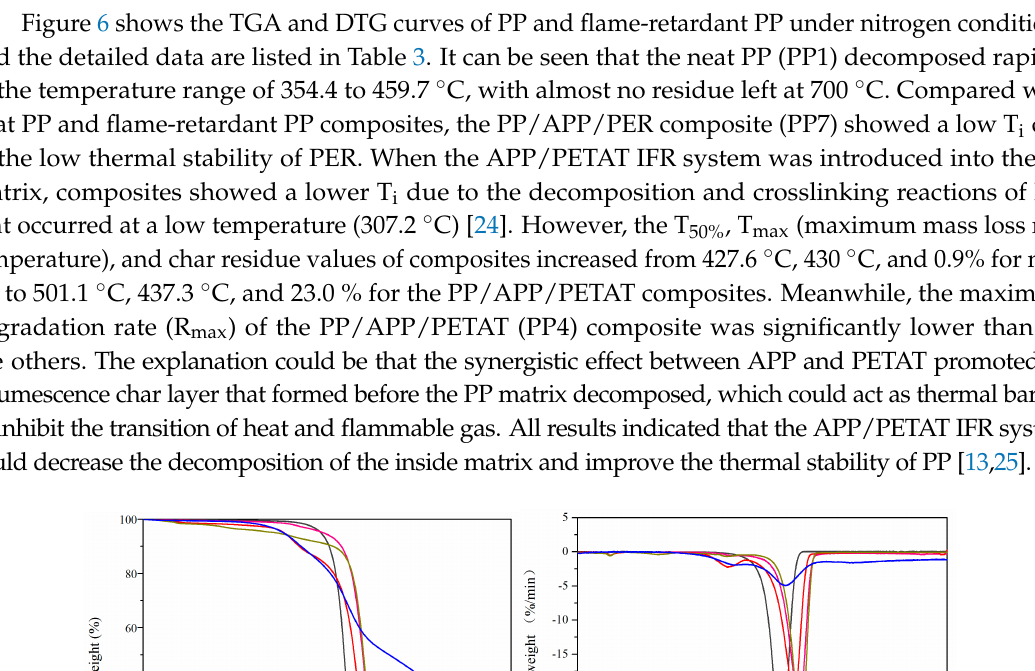
Figure 6. TGA ( a ) and DTG ( b ) curves of PP and PP composites under N 2.